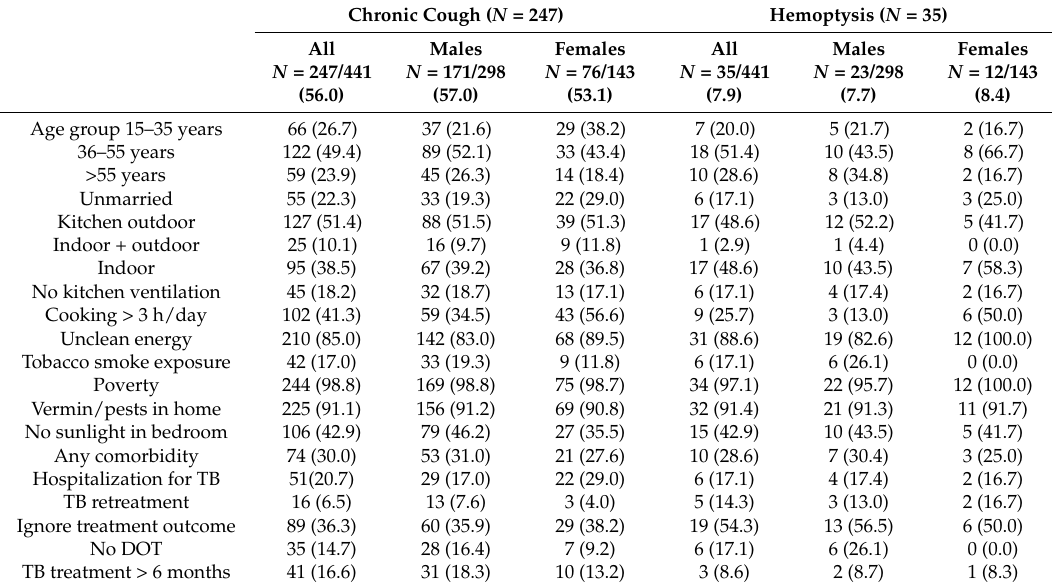
Table 2. Prevalence of self-reported chronic cough or hemoptysis and of selected covariates in 441 survivors of pulmonary TB in rural